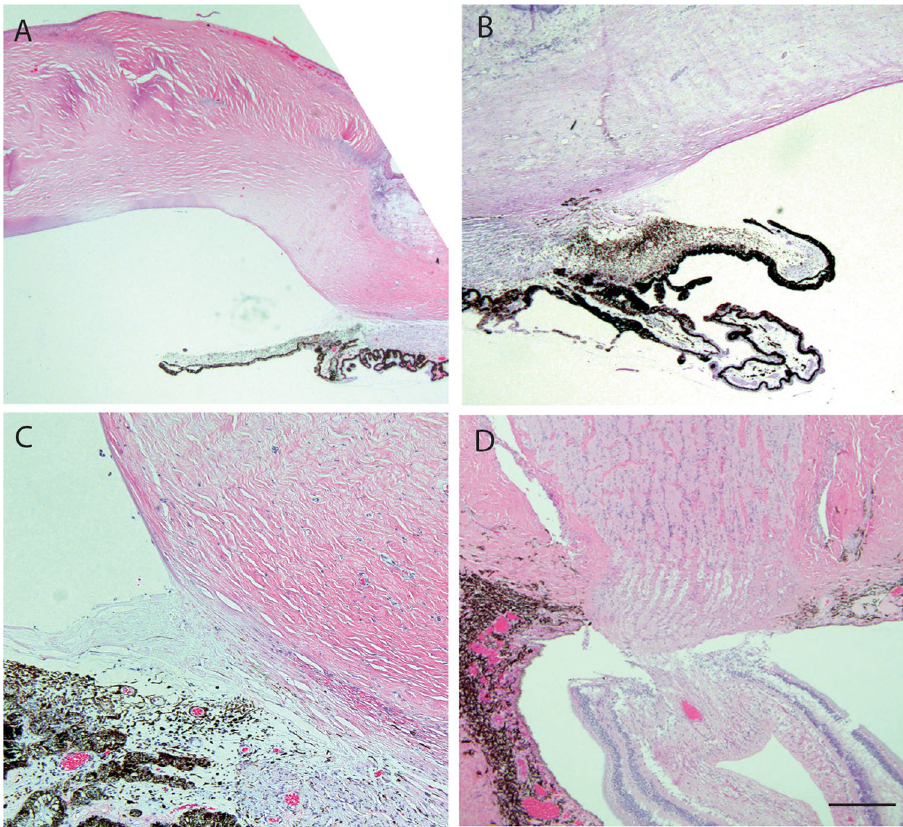
Figure 2. Ocular histopathology analysis of Lowe patient 2. ( A ) Cornea thickening and scarring with fibrovascular proliferation in the subepithelial region. Scale bar 1 mm. ( B ) The angle of the anterior chamber is covered in dense fibrous tissues adherent to the cornea and the iris stroma. Extensive ectropion uvea overlay the atropic iris. Scale bar 1 mm. ( C ) Ciliary body is underdeveloped and atrophic with peripheral staphyloma. Scale bar 0.5 mm. ( D ) Optic nerve shows loss of retinal ganglion cell layer, retinal gliosis, and cupping of optic nerve head. Scale bar 0.5